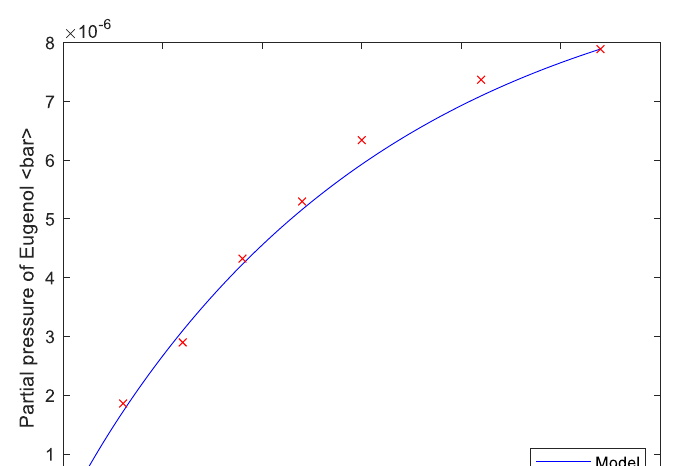
Figure 7. Modelling of Geraniol.